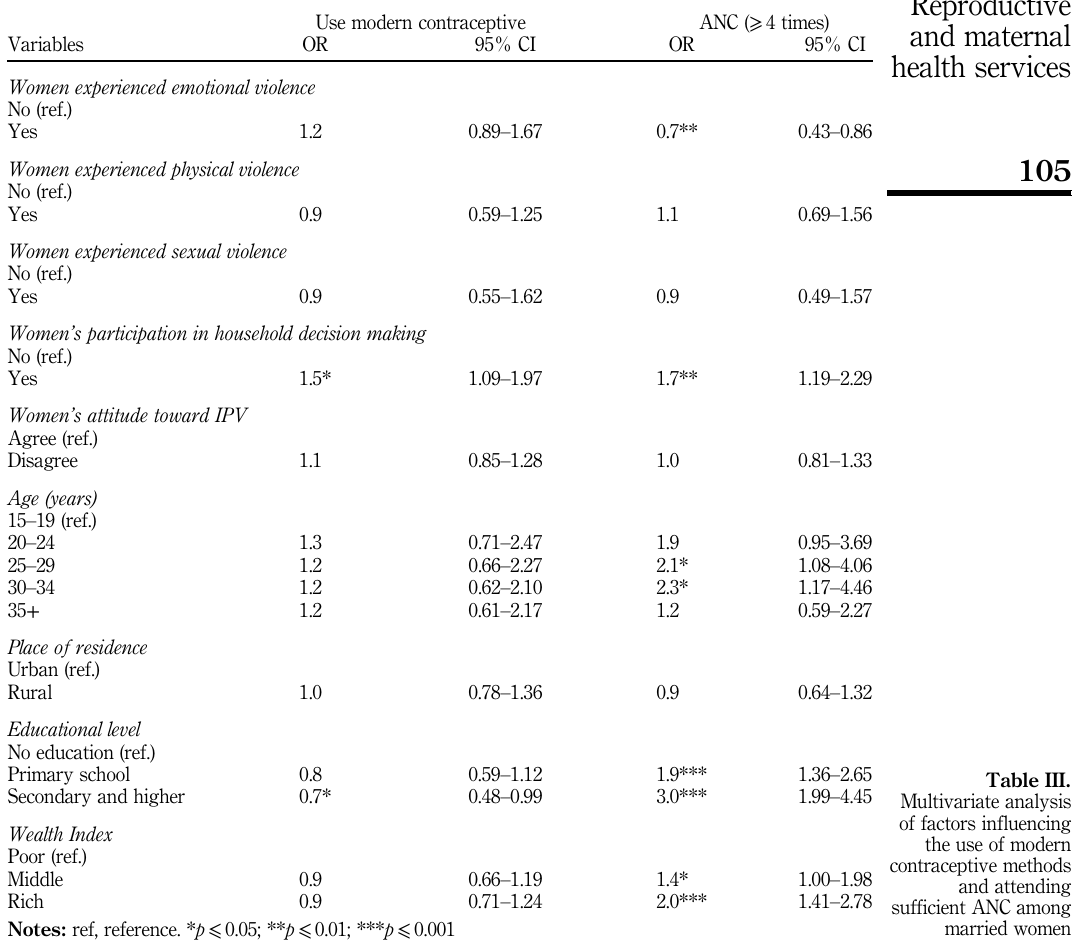
Table III. Multivariate